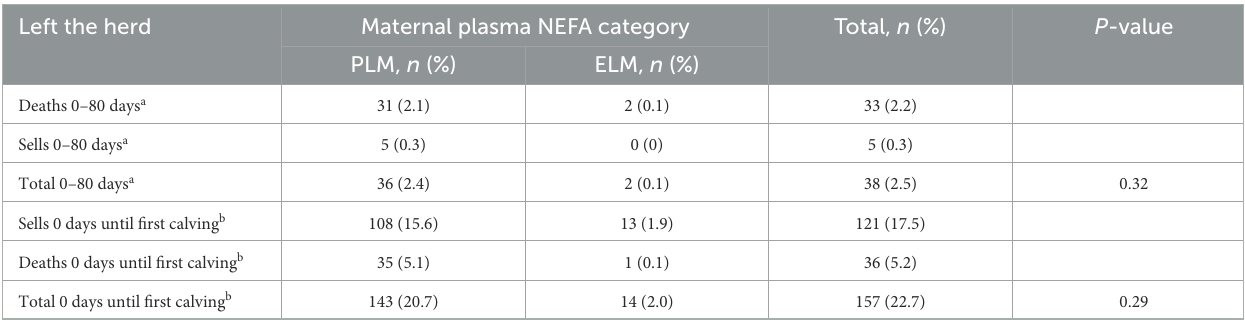
TABLE 5 Cause and proportion of calves and heifers that left the herd in the pre-weaned period or before the first lactation by maternal NEFA category in the late gestation. Left the